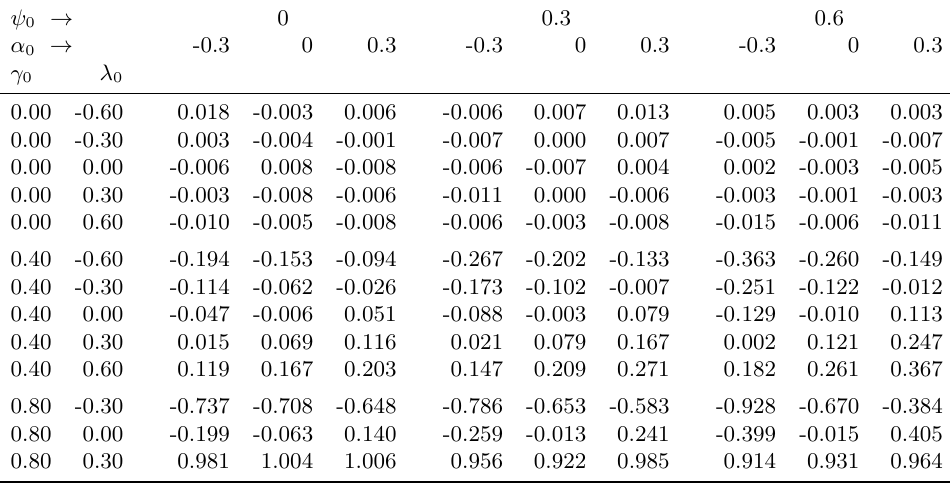
Table D.5: Bias of Team Spatial – spatial-autoregressive